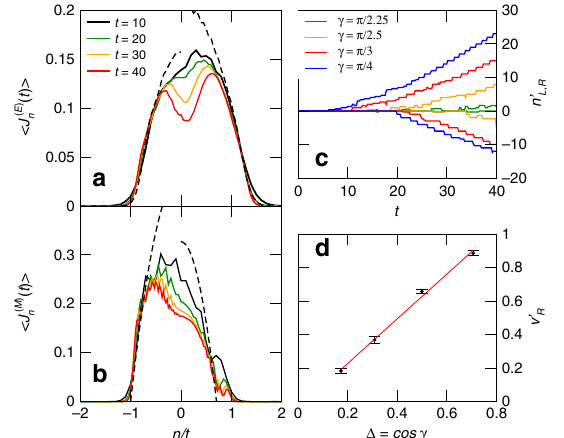
Fig. 3 Pro fi les of the energy and magnetization currents during the relaxation process. Energy-transport scenario: a energy current pro fi le for γ ¼ π = 4 and several values of time. Spin-transport scenario: b spin current pro fi le for γ ¼ π = 4 and several value of time. In both ( a ) and ( b ), the dashed lines for negative/positive values of n = t are the results of the simulation of an homogeneous systems with the parameters of the left/ right halves for t ¼ 40, respectively. Internal light cone: c space-time plot of the left/right maxima n 0 L = R of the energy current pro fi le for several values of γ (when only one maximum is detected we set n 0 n 0 L ¼ R ¼ 0); d extrapolated velocity v 0 R of the internal light cone computed by fi tting the data of ( c ) for 30 (cid:6) t (cid:6) 40. The red line is obtained by fi tting the data with v 0 R ¼ A Δ þ B which gives A ¼ 1 : 33 ± 0 : 06 and B ¼ (cid:3) 0 : 03 ± 0 : 03. Error bars represent the standard deviation of the fi tting